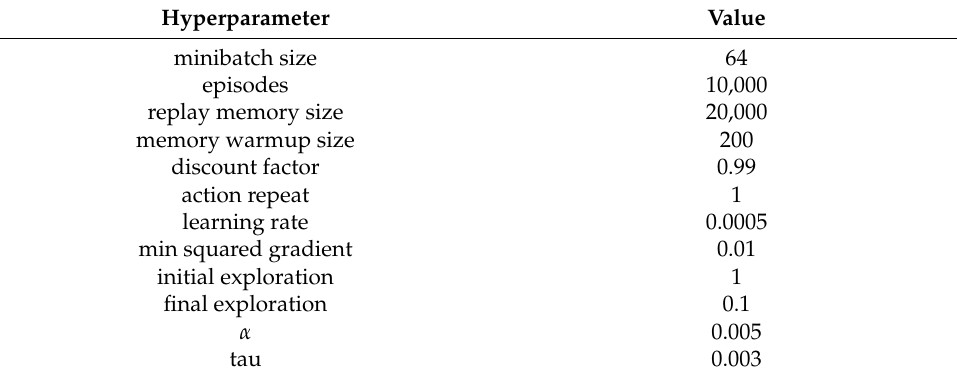
Table 1. Main hyperparameter settings of the algorithm.